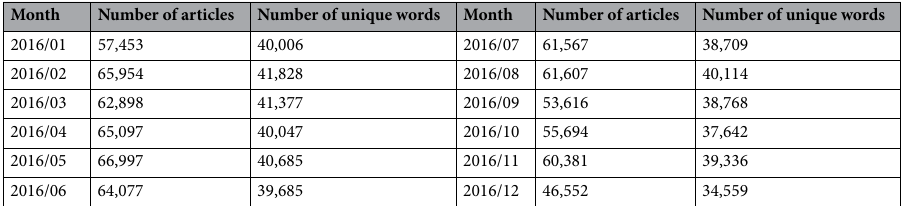
Table 4. Number of articles and unique words in 2016.